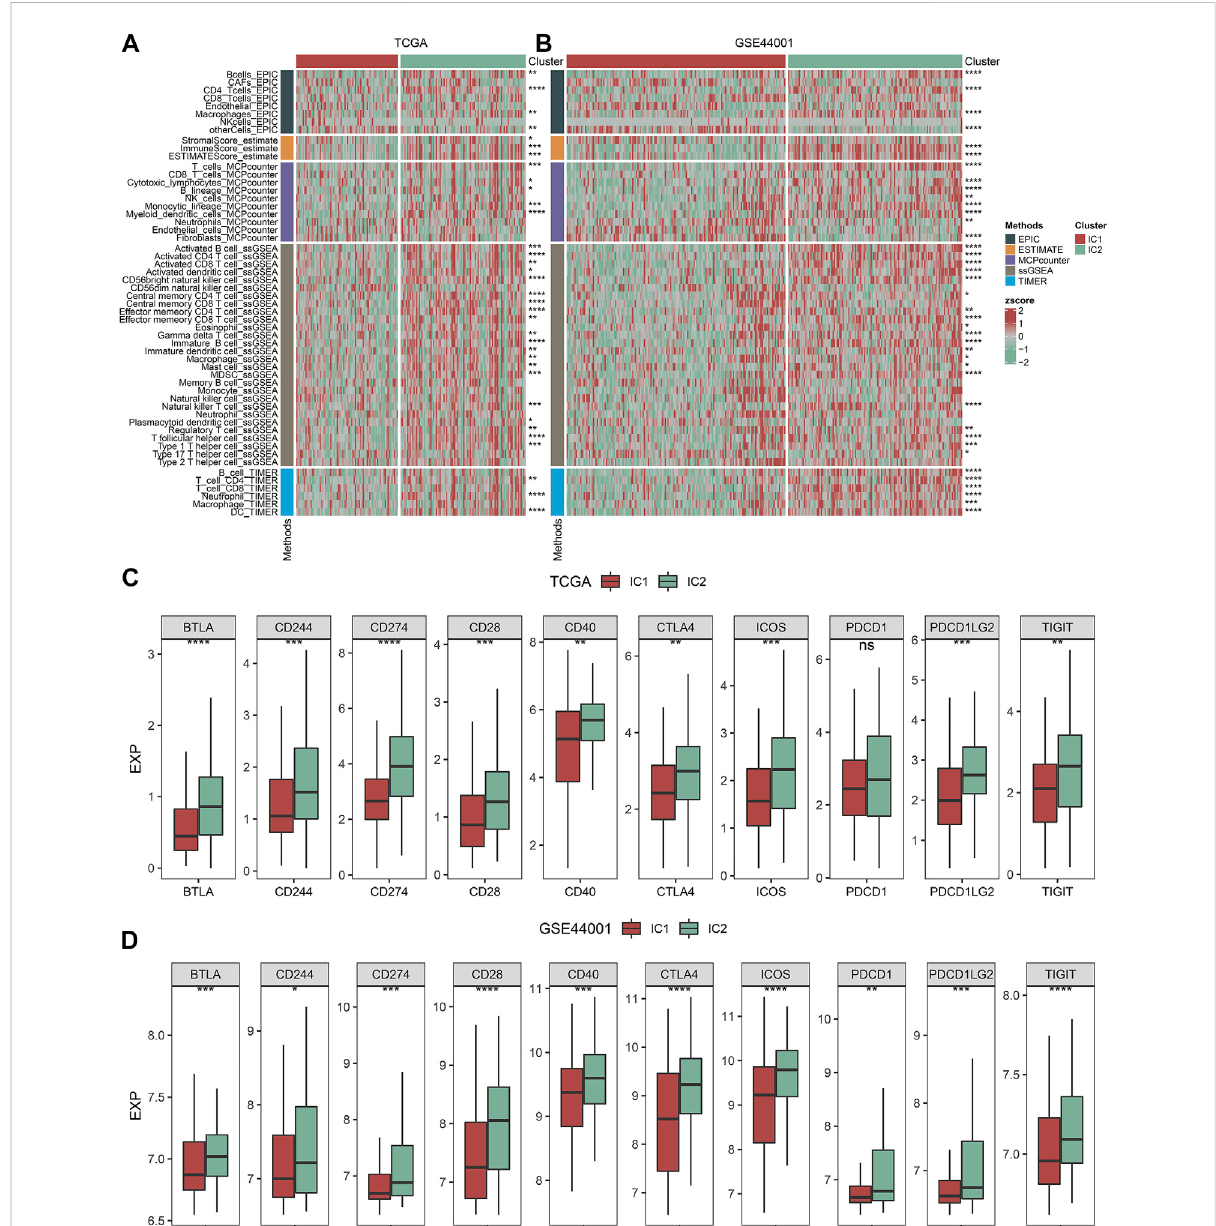
FIGURE 3 Immune subtypes with distinct immune microenvironment and immune checkpoints. (A,B) Heatmaps of the abundance of immune cells inferred by several approaches in IC1 and IC2 immune subtypes in the TCGA and GSE44001 datasets. (C,D) Expression of known immune checkpoints in two immune subtypes in the TCGA and GSE44001 datasets (ns: no signi fi cance; * p < 0.05; ** p < 0.01; *** p < 0.001; **** p <